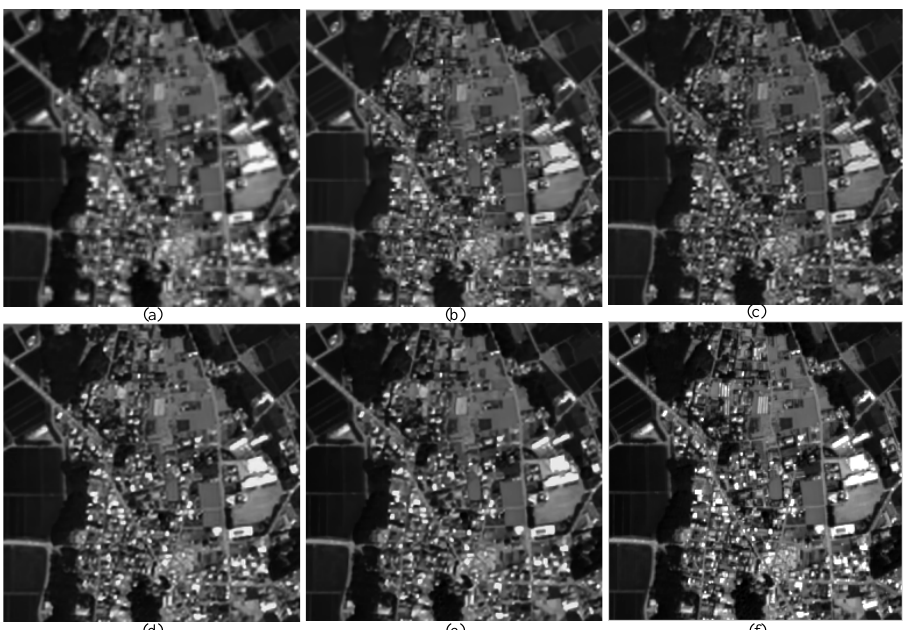
Figure 8. The SR results (band 20) of different methods by an upscaling factor of two, the testing data is cropped from Chikusei with size 256 × 256. ( a ) Result of Bicubic, ( b ) result of SSG [27], ( c ) result of SRCNN [40], ( d ) result of 3D-CNN [32], ( e ) result of the proposed MW-3D-CNN, and ( f ) original HR image.